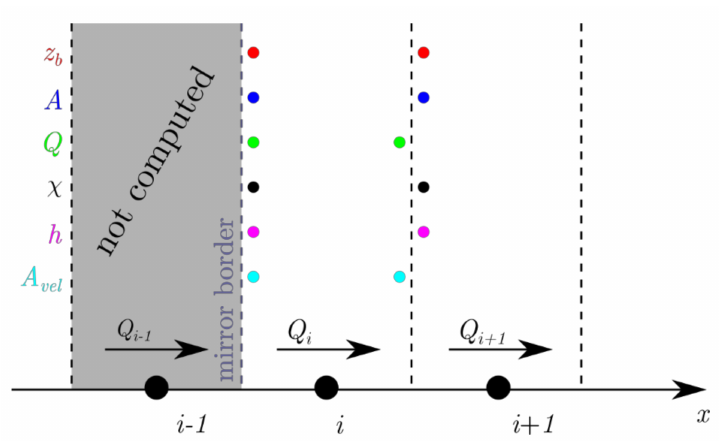
Figure 1. Upwinding directions of the unknown and flow properties at the upstream limit of the computation